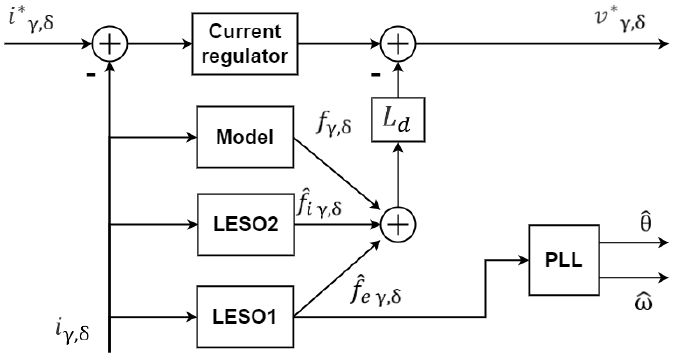
Figure 5. Implementation scheme of sensorless control based on linear disturbance observers in [21].